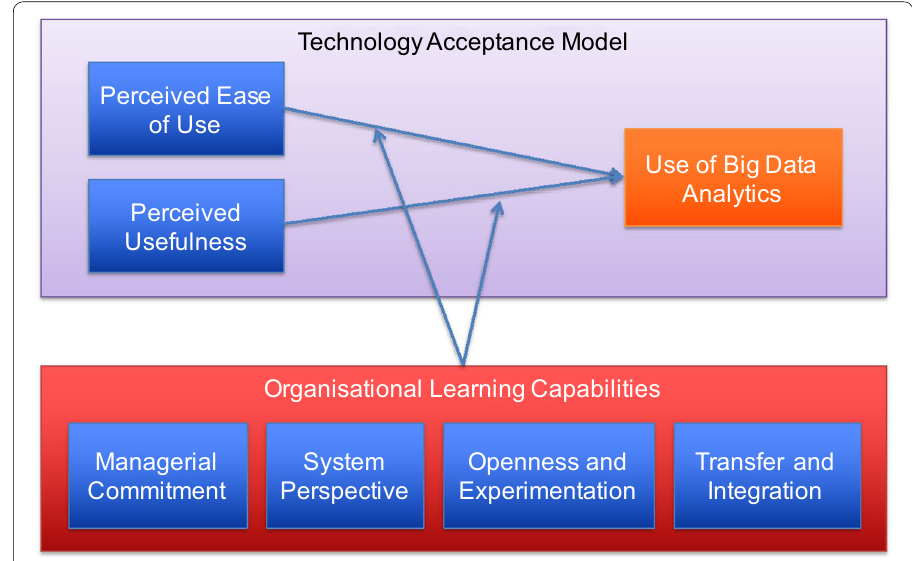
Fig. 5 Theoretical Framework for Evaluating the Intended Usage of Big Data (Source: Adapted from Davis [9] and Jerez-Gomez et al.